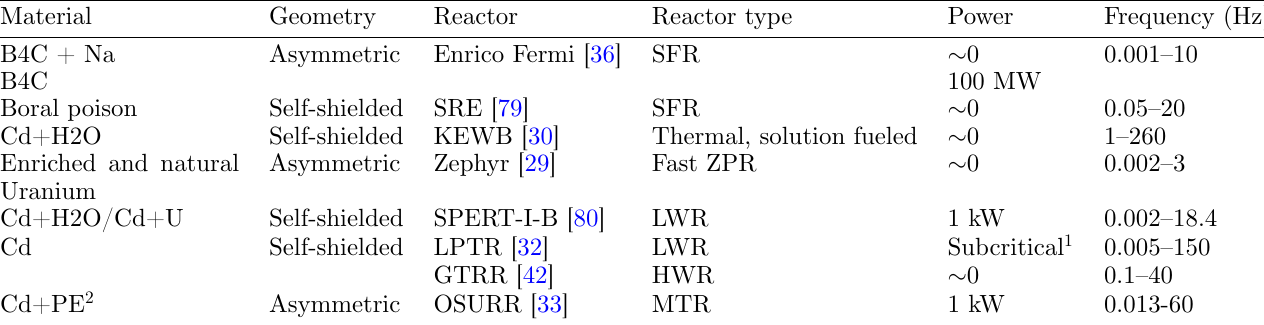
Fig. 7. Typical geometries of rotary modulators (after [78]). Table 2. Typical rotary rod oscillator in past experimental